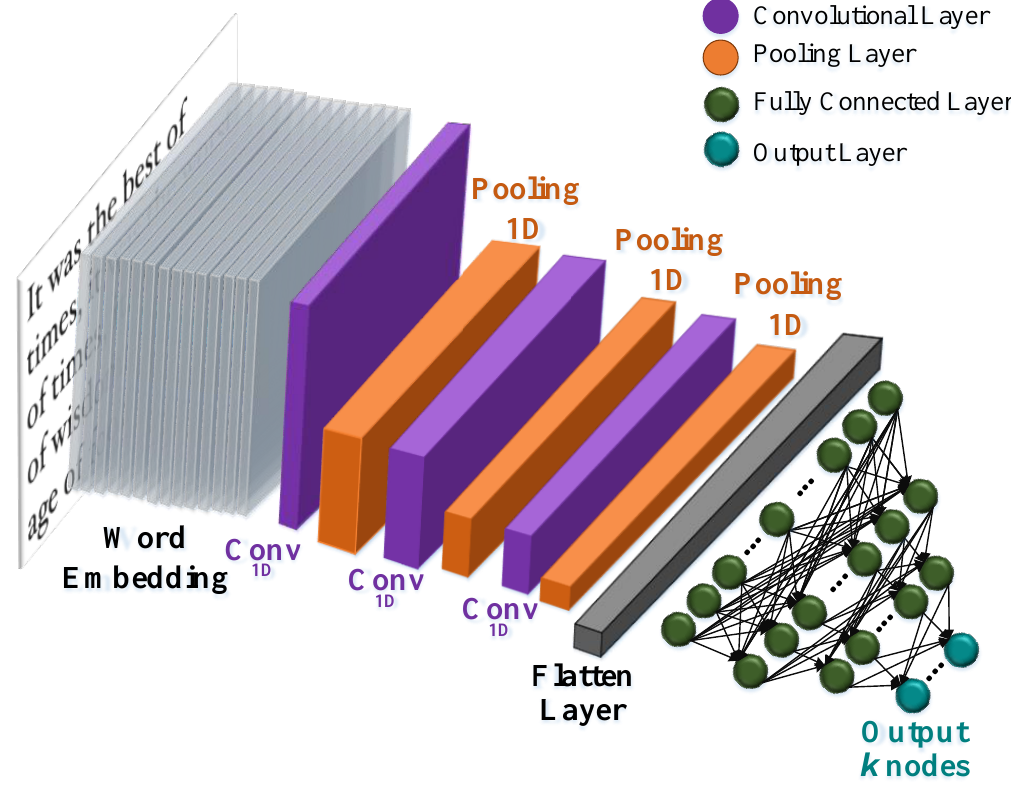
Figure 19. Convolutional neural network (CNN) architecture for text